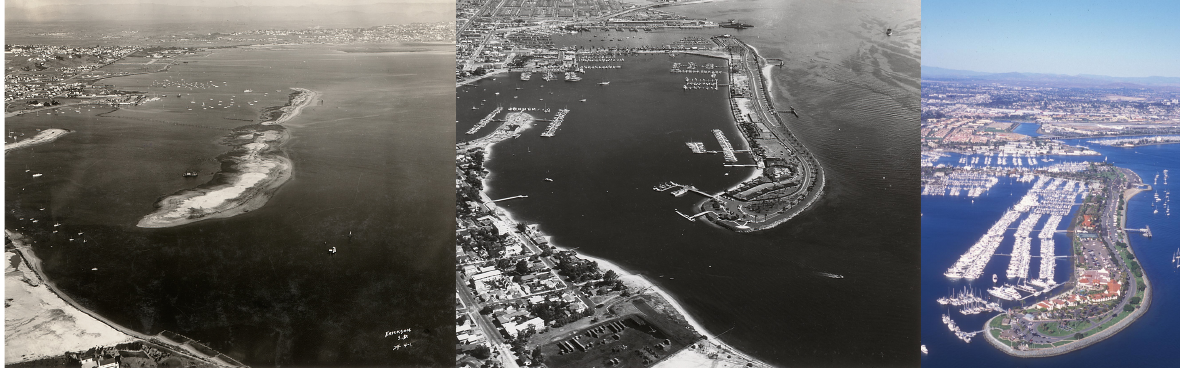
Figure 3. View of Shelter Island in 1937, the 1950s and the 1990s, left to right. Photos courtesy of Unified Port of San Diego [1]. An example of extreme transformation showing how the sand spit, or “mud island” as it was referred to, now offers home to numerous vessels. View is southwest to northeast. The entrance to Shelter Island has also been subject to high currents in past tsunamis (e.g., 22 May 1960, Chile and 11 March 2011, Japan; [4]).